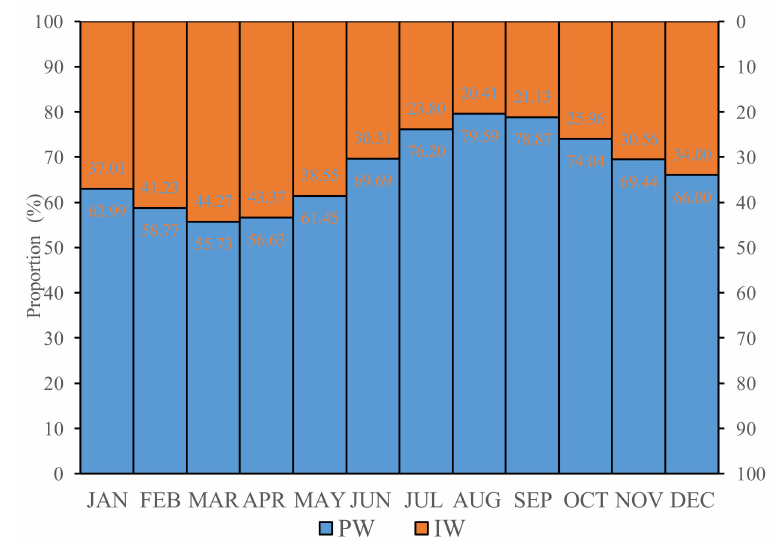
Figure 3. The proportions of the Indian Ocean Warm Pool (IW) and Pacific Ocean Warm Pool (PW) in the IPWP during seasonal